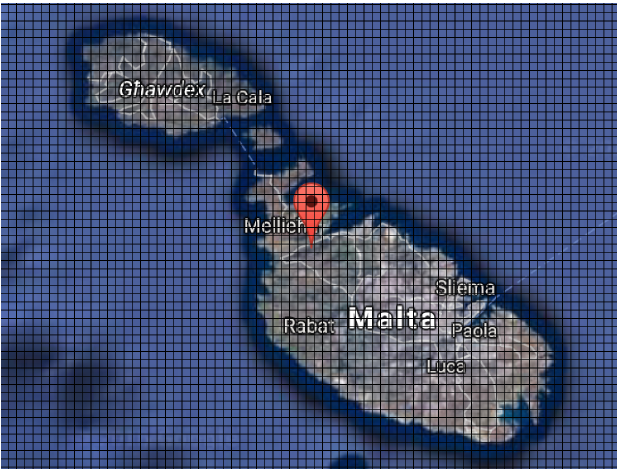
Figure 9. Example of area split into